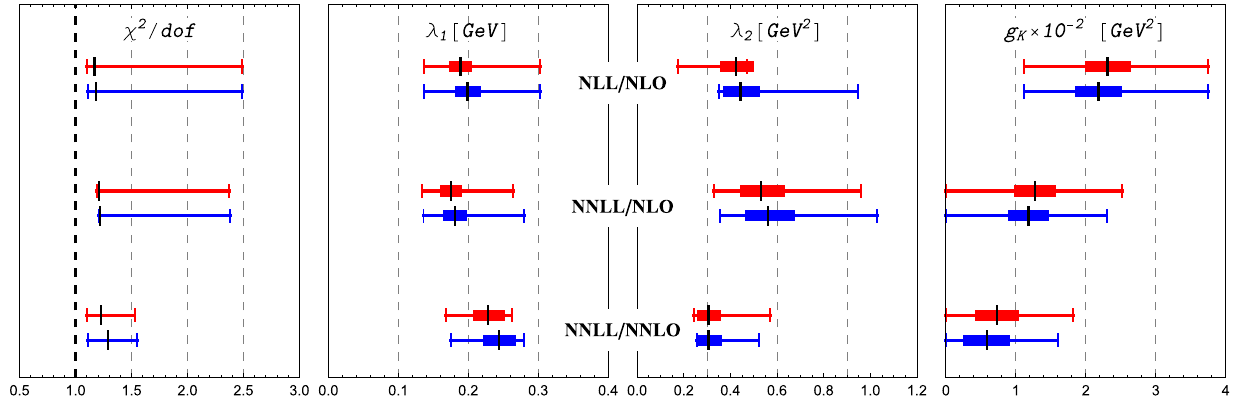
Fig. 9 The values of parameters for f NP extracted from the global fit with g K (cid:16)= 0. Red marks represent the extraction with model 1. Blue marks represent the extraction with model 2. The black marks show the valuesofparametersextractedat c 1 , 2 , 3 , 4 = 1.Thethickbandsrepresent